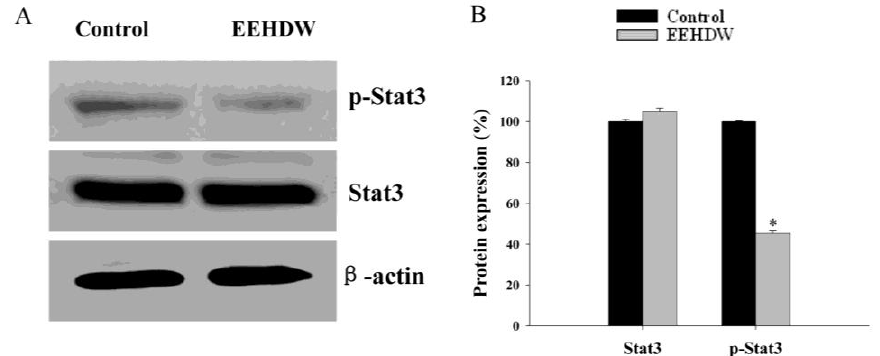
Figure 4. Effect of EEHDW on phosphorylation of STAT3 in CRC xenograft mice. ( A ) Three tumors were randomly selected from each group and the level of STAT3